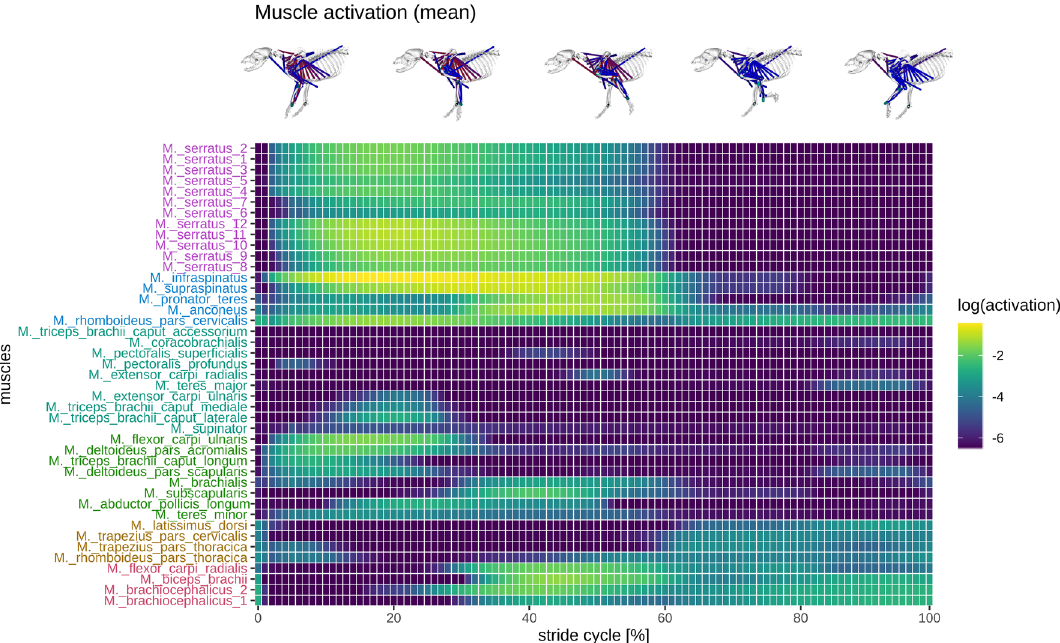
Figure 3. Simulated forelimb muscle activation in a walking Beagle during one gait cycle, shown as a heatmap of logarithmic values (log2). The plot shows how individual muscles were activated based on consecutive strides of the same trial. The muscle groups (colours) were arranged according to hierarchical clustering (method— ward.d2) and minimal leaf sorting. The figures were created with the software packages OpenSim 28,29 and R 70